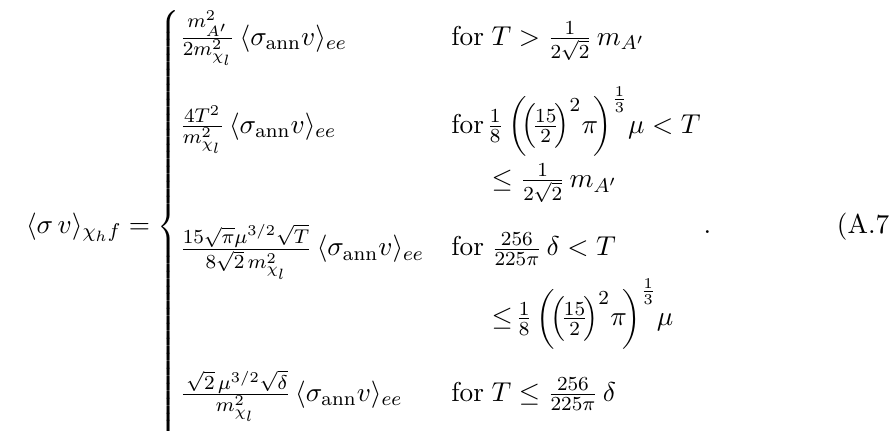
Figure 14 . Plot of the approximation for the cross section times velocity for the scattering χ h e ± → χ l e ± for masses m χ line correspond to full expression for the cross section, the colored lines are the cross section